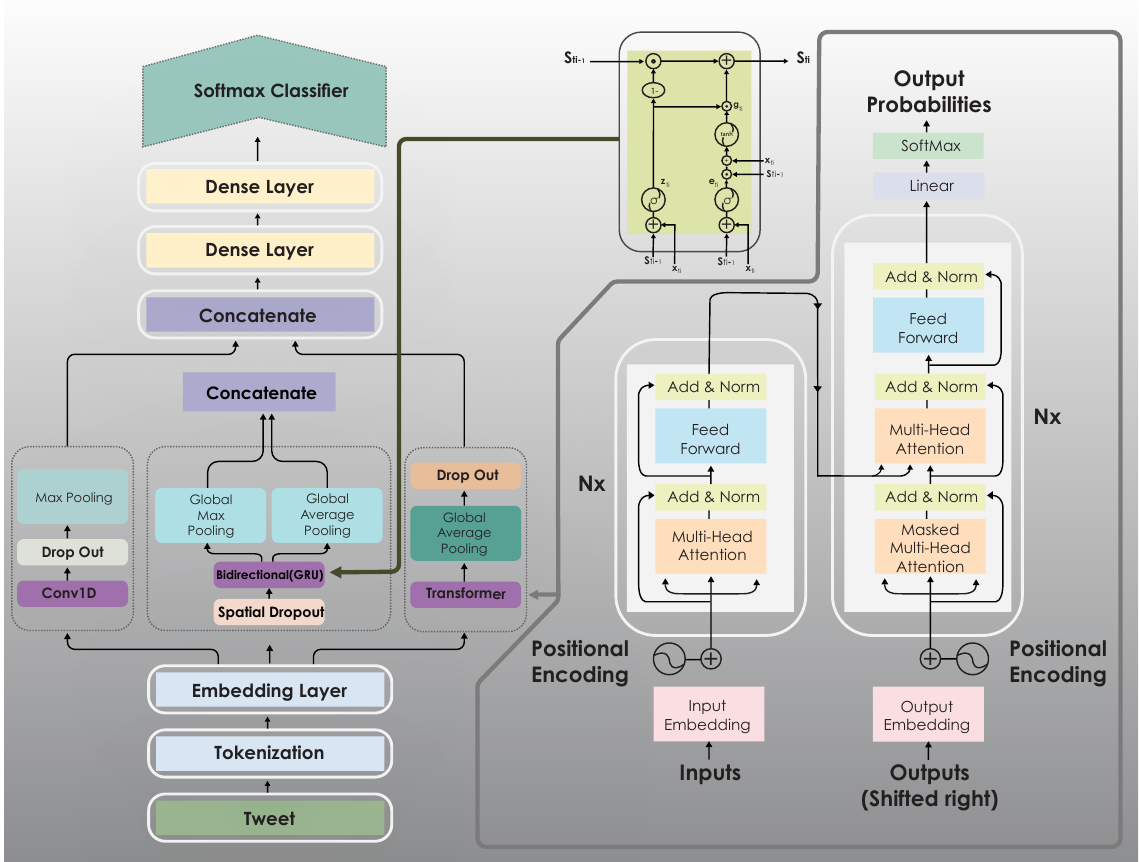
Figure 2. The proposed multichannel deep learning